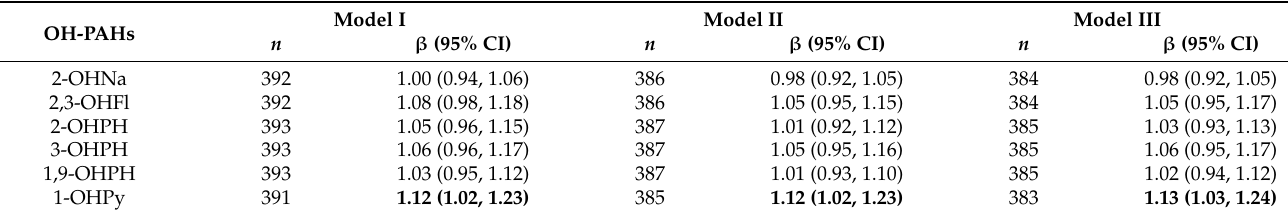
Table 3. Linear regression analyses of urinary OH-PAHs concentrations with hair cortisol